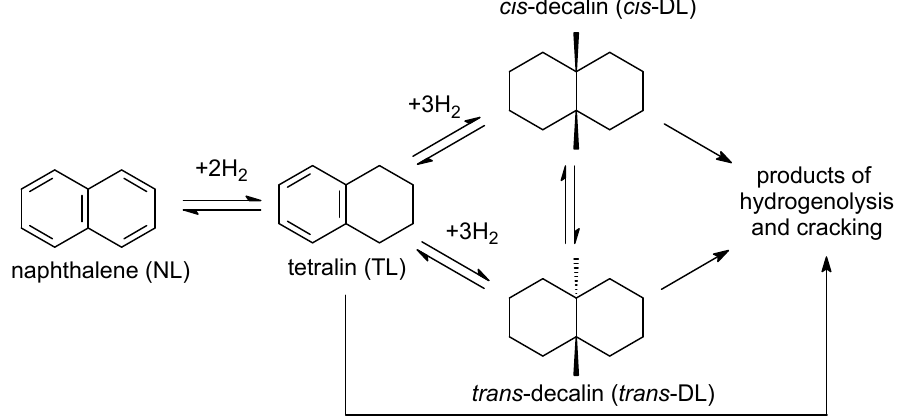
Figure 1. Schematic presentation of naphthalene (NL) hydrogenation.